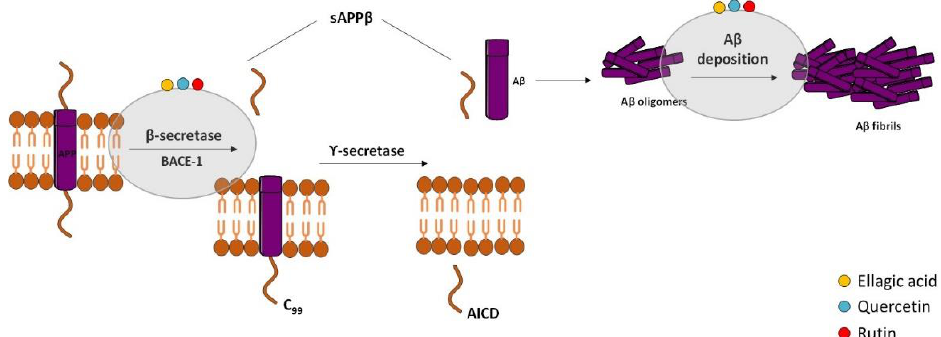
Figure 2. Effect of compounds obtained from E. globulus leaves in the amyloidogenic pathway and in the formation of amyloid- β (A β ) in AD. The amyloidogenic pathway is initiated with the enzymatic breakdown of amyloid precursor protein (APP) by β -secretase enzyme followed by catalytic cleavage of APP by γ -secretase to originate non-soluble protein or A β . A β oligomerization and accumulation leads to synaptic dysfunction and neurodegeneration.